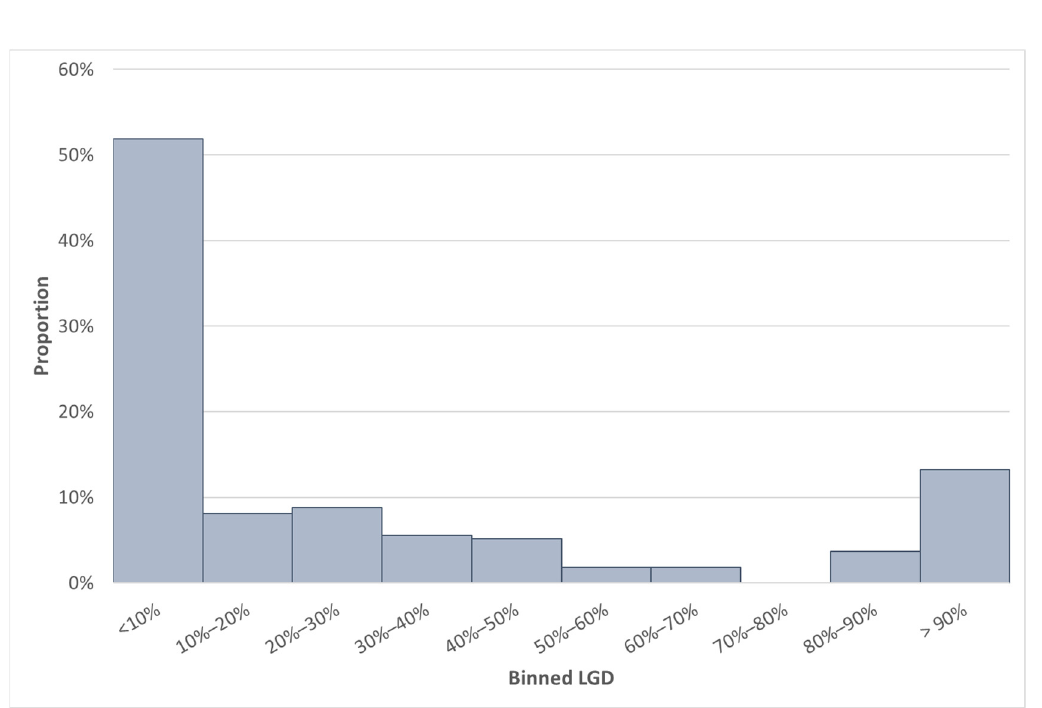
Figure 5. LGD distribution of Country L.